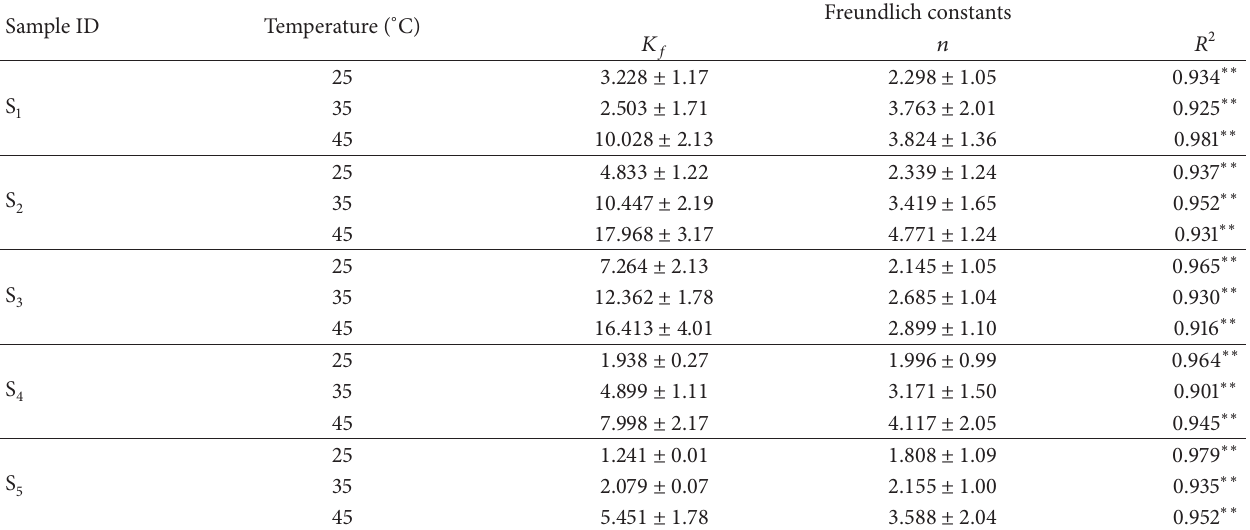
Table 4: Freundlich constants of Cd sorption in soils (data represent mean of tree replications ± SD). Sample